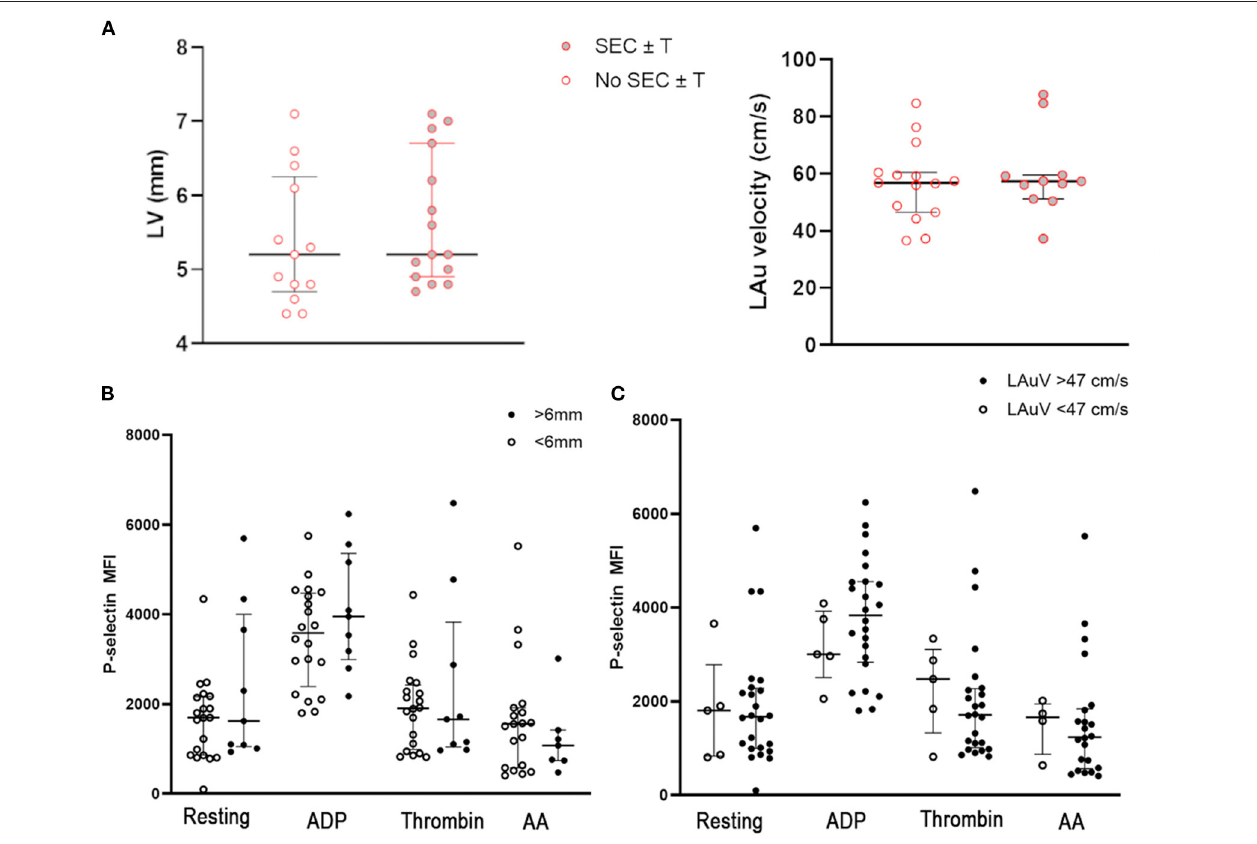
FIGURE 7 | (A) Myocardial thickness, measured based on maximum wall thickness of the left ventricle (LV) and left atrial function, assessed by left auricular flow velocity (LAuV) did not differ among cats exposed to wildfires with or without spontaneous echocardiographic contrast ± intracardiac thrombi (SEC ± T). (B) Platelet activation in 29 cats, measured as P-selectin median florescence intensity (MFI) at rest or in the presence of 20 µ M ADP, thrombin or 1 µ M arachidonic acid (AA). Platelet activation did not differ among cats with evidence of myocardial thickness. (C) Similarly, there was no evidence of increased platelet priming in cats with normal or low left auricular flow velocity